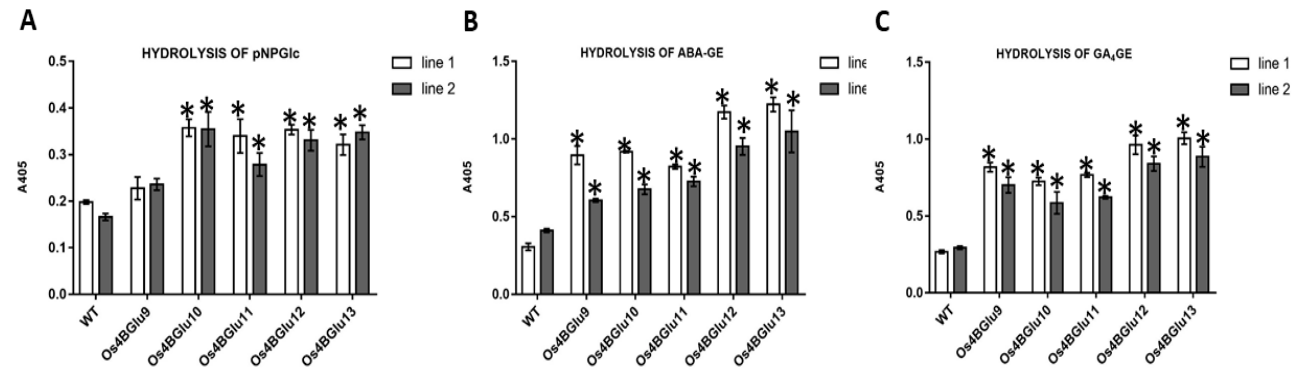
Figure 4. Hydrolysis of ABA-GE, GA 4 -GE and p NPGlc by plant extracts. Hydrolysis activity of extracts of wild type Col-0 Arabidopsis and transgenic Arabidopsis expressing rice β -glucosidase with p NPGlc ( A ), ABA-GE ( B ) and GA 4 -GE ( C ). Two independent lines of transgenic Arabidopsis expressing rice β -glucosidases Os4BGlu9-13 were grown under the same conditions. Three separate plant extracts were made for each line and extracts were incubated at 30 ◦ C for 4 h in each substrate reaction. The asterisks (*) above the bars indicate significant differences from both control lines with a p -value <